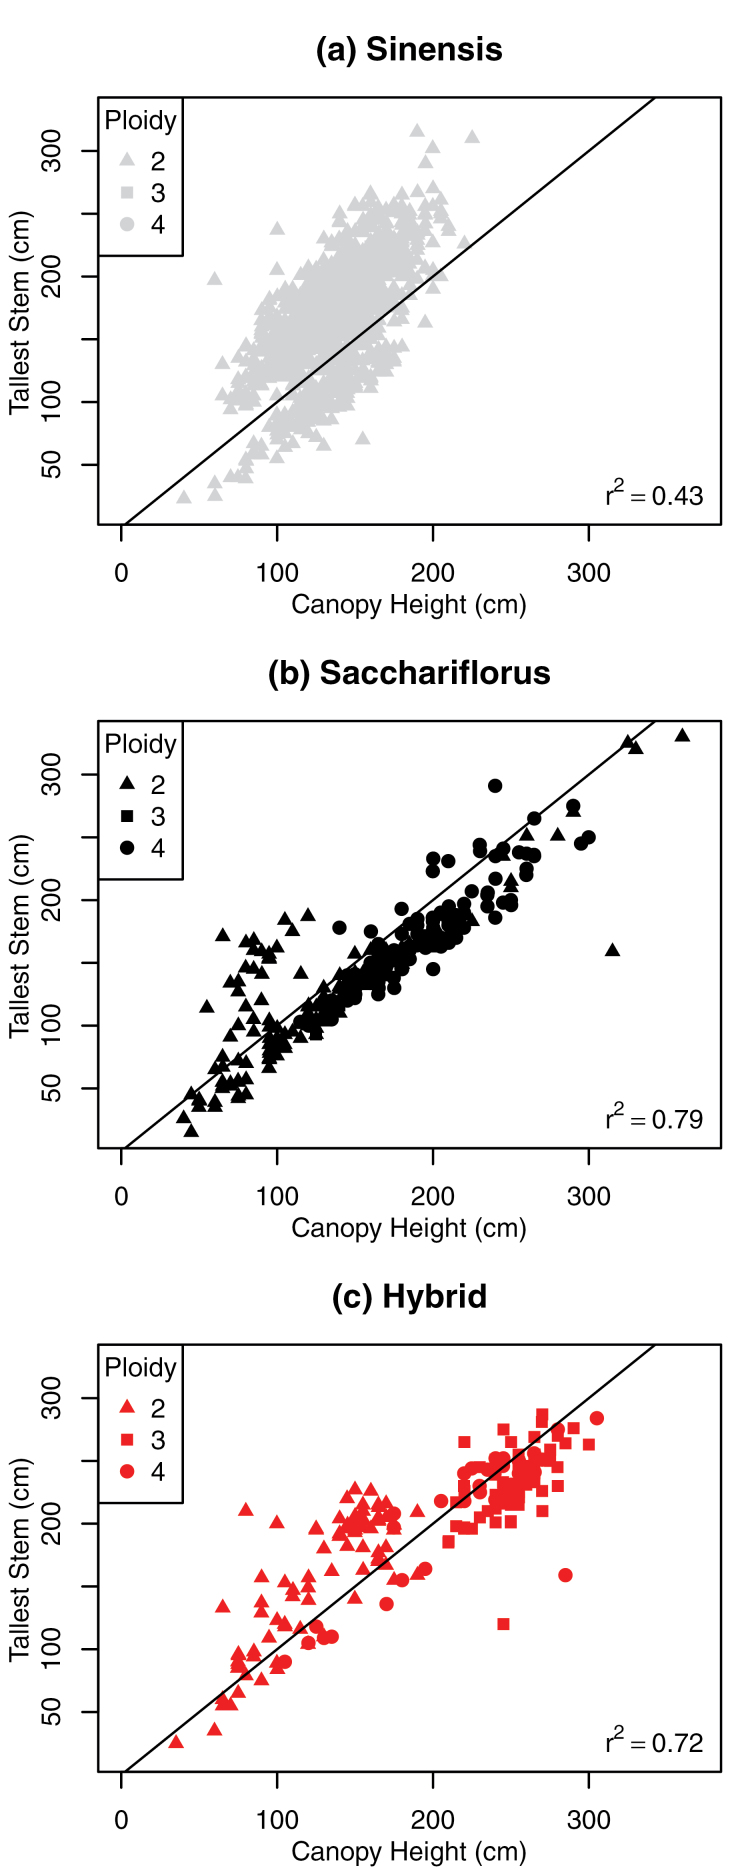
Pairwise trait plots between tallest stem and canopy height for all replicates for Y4 and Y5 by species: M. sinensis (grey), M. sacchariflorus (black), and hybrid (red); and by ploidy: diploid (triangle), triploid (square) and tetraploid (circle).